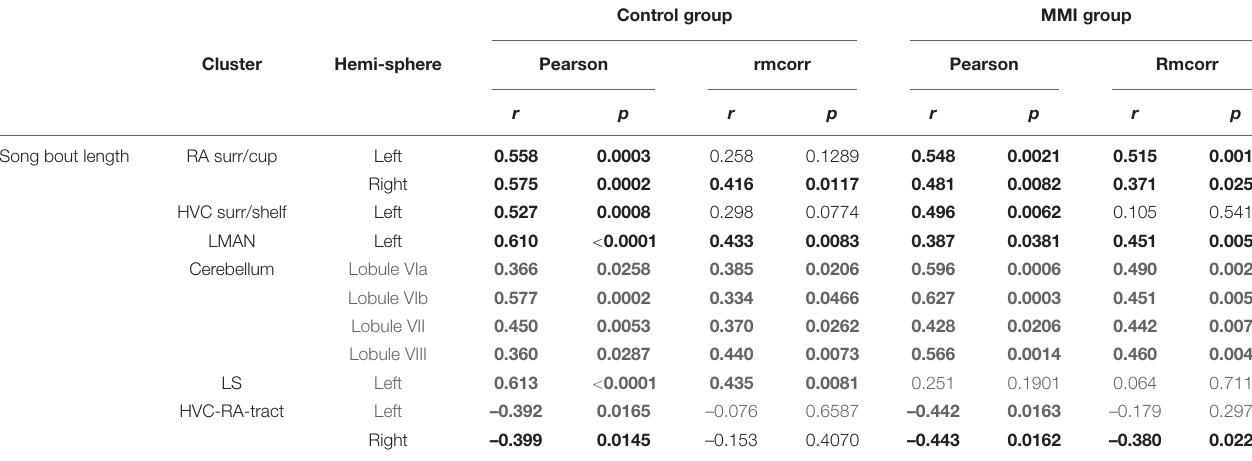
TABLE 4 | Summary of the overall and repeated measures correlation of song bout length for control and MMI-treated group separately. Control group MMI group Cluster Pearson